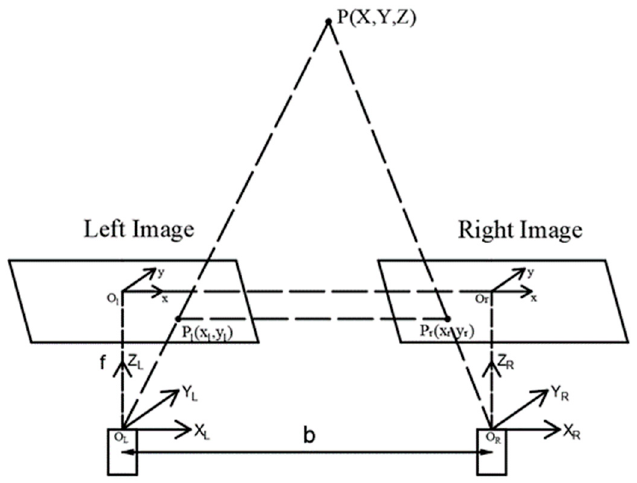
Figure 4. Positioning principle of a binocular camera. O L -X L Y L Z L and O R -X R Y R Z R are the left and right eye coordinate systems of the binocular camera, respectively; OL and OR are the optical centers of the left and right eyes, respectively; f is the focal length of the binocular camera; b is the baseline distance of the binocular camera. The coordinates of the tea to be located are point P in the camera coordinate system, and its coordinates are (X, Y, Z).